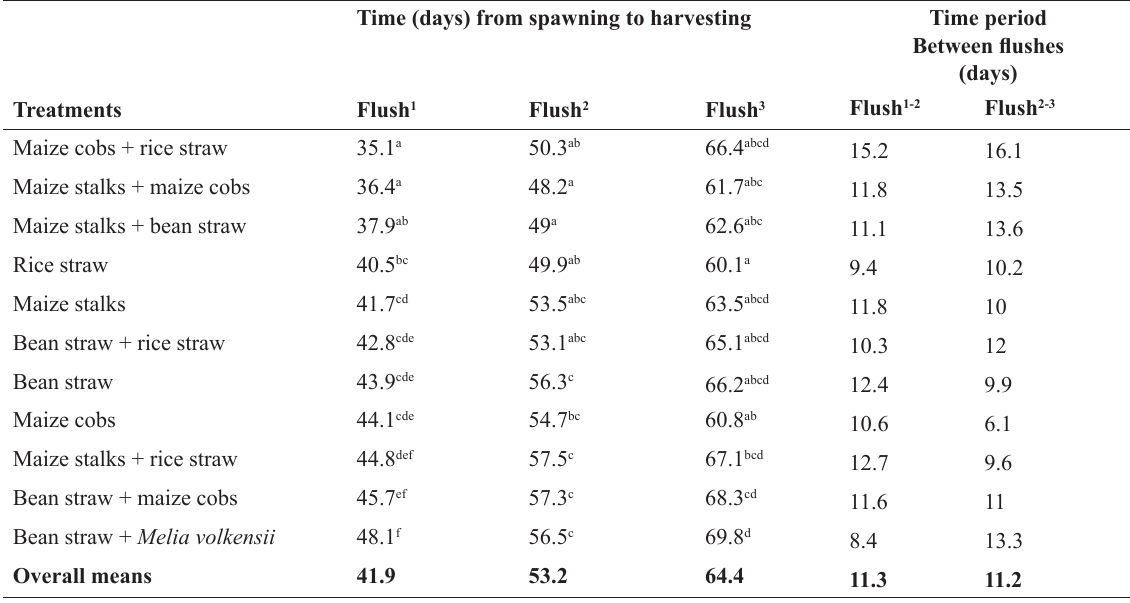
Table 2 Time from spawning to the beginning of mushroom fruiting, in function of substrate composition Time (days) from spawning to harvesting